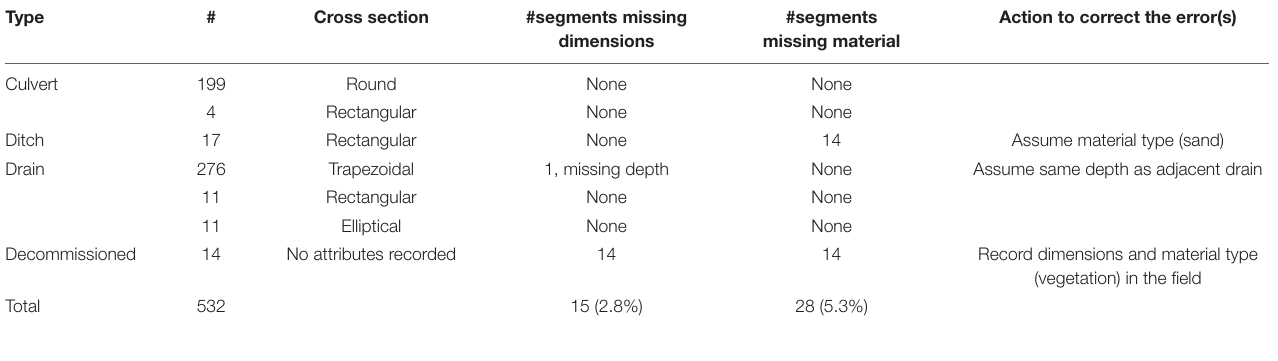
TABLE 5 | Analysis of attribute